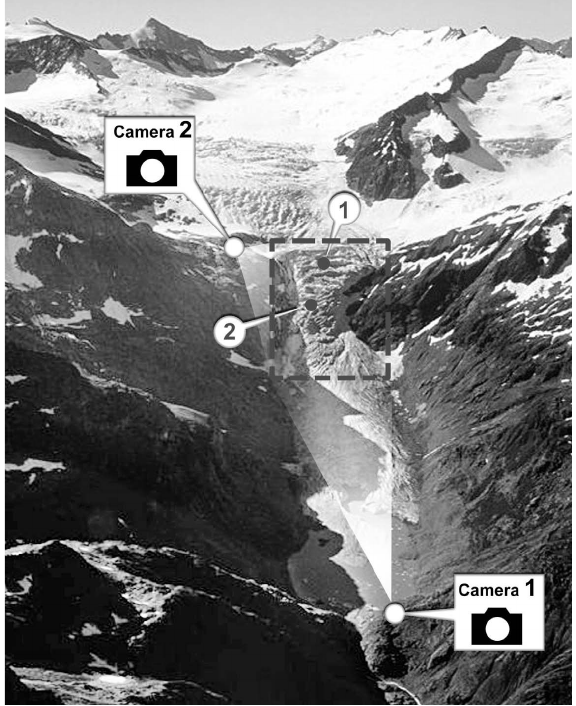
Fig. 14. Triftgletscher and locations of the two automatic cameras. The critical steep glacier sector is marked by the box. Time series of surface motion were determined for the points 1 and